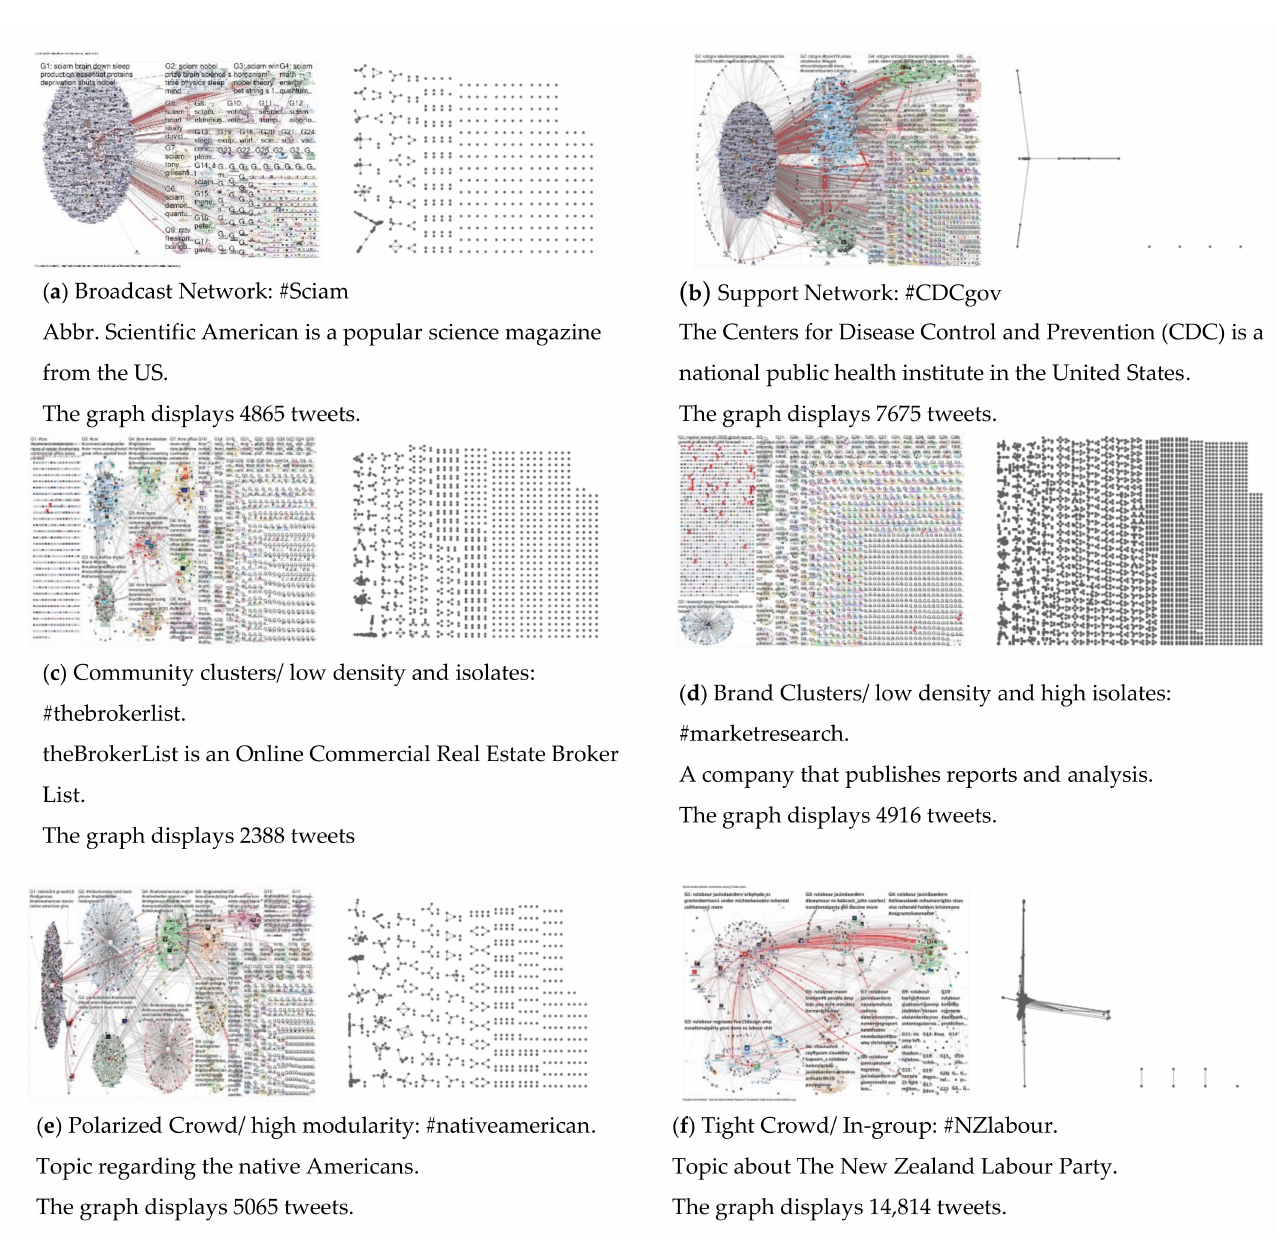
Figure 1. Examples of datasets that have been classified according to procedures are listed in Figure 2 [27]. Each of them represents a topic network with specific patterns of information flow. Under each figure, there is an explanation about the topic and the main hashtag used in the discussion of the pictured